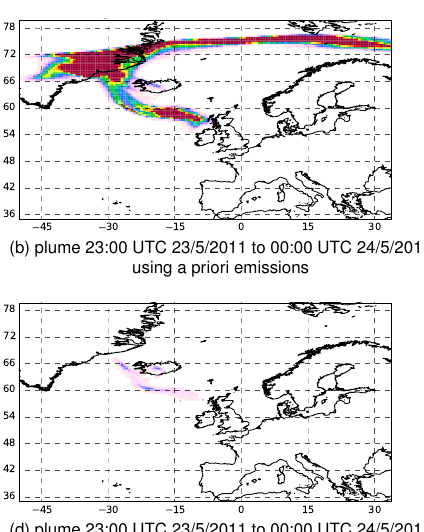
Run Date: February 28, 2018